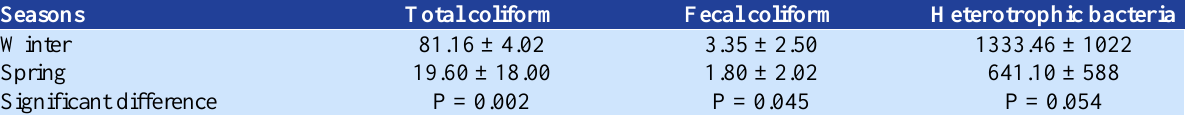
Table 2. Concentration of coliforms and heterotrophic bacteria (number /100 ml) in the water distribution network in two